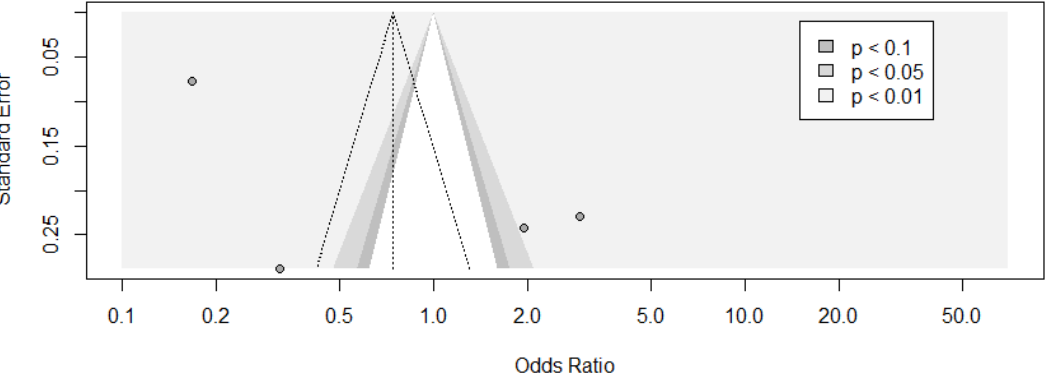
Figure 8. The contour funnel plot of the meta-analysis of ESS ≥ 10 and car crashes with contours of statistical significance at 1%, 5% and 10%. It is helpful to investigate if in a meta-analysis, some studies might have been suppressed based on their statistical significance. This representation facilitates the assessment of whether the areas where studies exist are areas of statistical significance and whether the areas where studies are potentially missing correspond to areas of low statistical significance. Three small studies with positive significant effects and one with a negative significant result despite having a large standard error were observed. One study with a large standard error reported a nonsignificant positive result. In the upper side of the plot, there was only a large study presenting a result with p < 0.01.